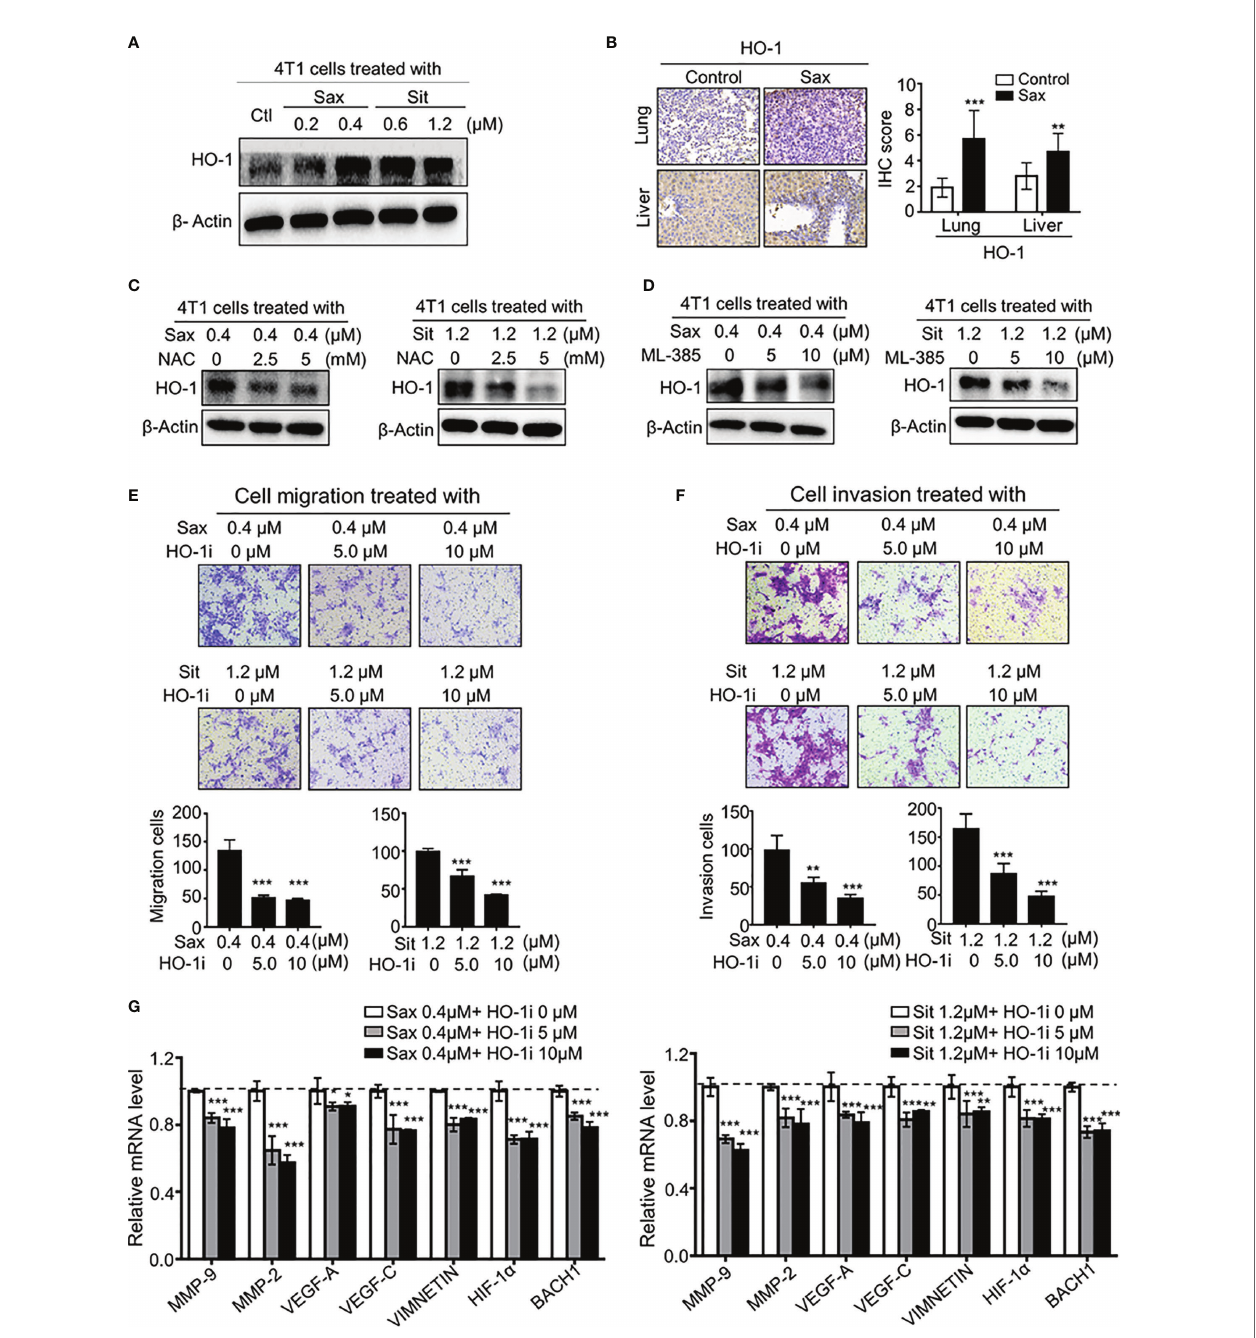
FIGURE 6 | ROS-NRF2 dependent HO-1 activation is critical to DPP-4i-driven BC metastasis. (A, B) DPP-4i enhances NRF2-responsive HO-1 activation. HO-1 expression was analyzed by western blotting in DPP-4i-treated 4T1 cells (A) and by IHC staining in lung and liver metastasis tissues (B) , respectively. (C) ROS inhibition abrogates DPP4i-induced HO-1 activation. 4T1 cells were co-treated with DPP-4i and NAC and HO-1 expression were detected by western blotting. b - actin was a loading control. (D) NRF2 inhibition attenuates DPP-4i – induced HO-1 activation. 4T1 cells were co-treated with DPP-4i and NRF2 speci fi c inhibitor ML- 385, and HO-1 expression were detected by western blotting. b -actin was a loading control. (E, F) HO-1 blockage reverses DPP-4i -driven BC cell migration and cell invasion in vitro . 4T1 cells were subject to cell migration (E) and cell invasion (F) upon co-treatment with DPP-4i and HO-1 speci fi c inhibitor for 24 h. Migration or invasion cells were counted in 5 to 10 random fi elds. (G) HO-1 blockage abrogates DPP-4i – driven metastasis-associated gene levels. 4T1 cells were co-treated with or without DPP-4i and HO-1 inhibitor for 4h and metastasis-associated gene levels were detected by qRT-PCR. b -Actin gene was as an internal control. Data are presented as mean ± SD of three independent experiments. Representative images are shown. Scale bar: 50 m m. *p<0.05, **p<0.01, and *** p<0.001 between the indicated groups determined by one-way analysis of variance